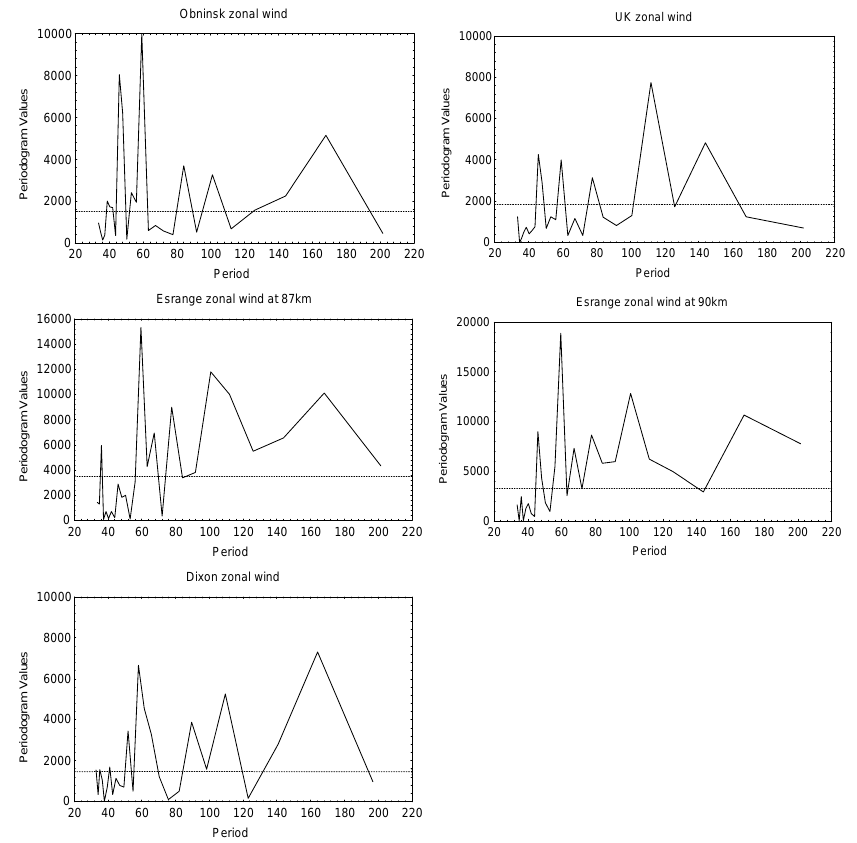
Fig. 8. (a) Spectra of zonal wind oscillations from 21 July 2000 to the end of measurements.